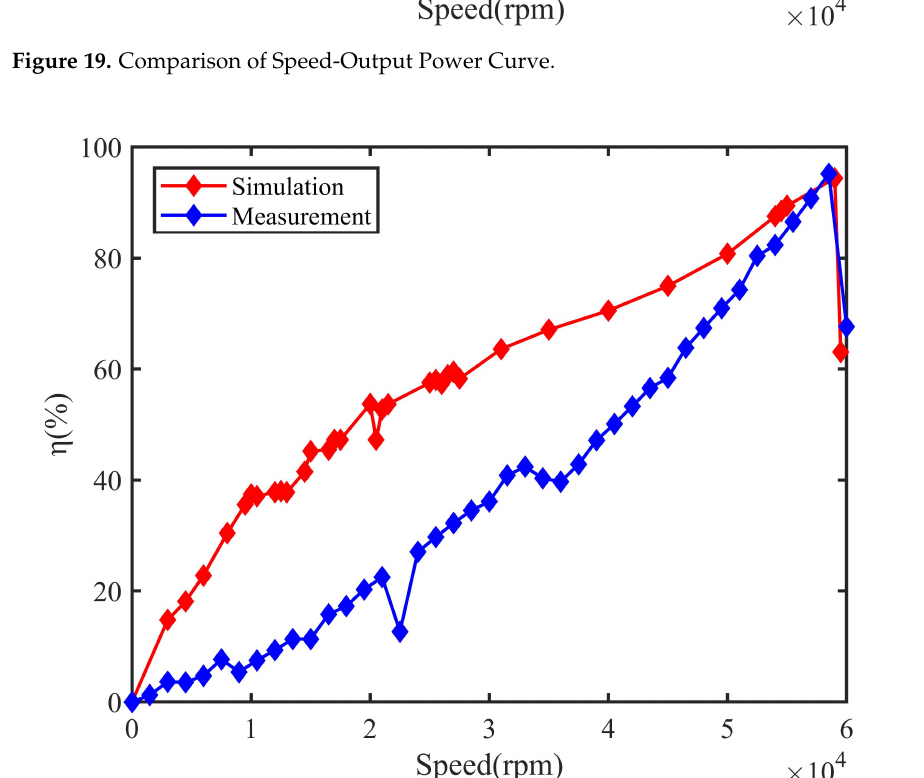
Figure 20. Comparison of Speed-Efficiency